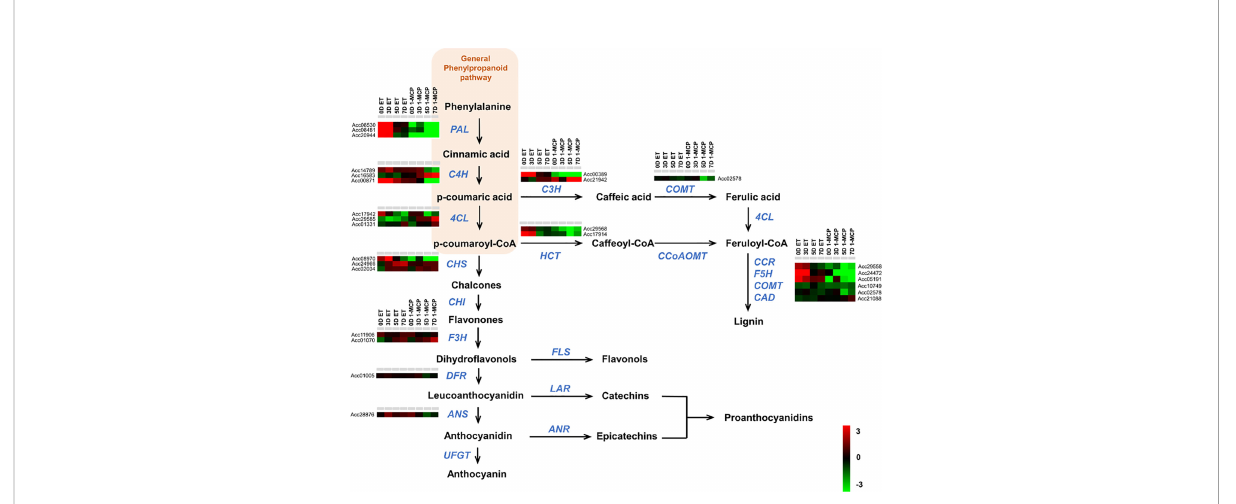
FIGURE 6 Expression pro fi les of phenylpropanoid pathway genes upon ET and 1-MCP treatment along ripening time course. Schematic diagram showing phenylpropanoid pathways beginning from general phenylpropanoid pathway constituting PAL , C4H , and 4CL genes and then subsequently branched into different biosynthesis pathways for anthocyanins, proanthocyanidins, and lignin. Gene names responsible for each step of the phenylpropanoid pathway were indicated with italicized blue-colored letters. Expression levels of genes related to each step of the phenylpropanoid biosynthesis pathway were presented as a heatmap. Red cube represents upregulated gene expression, and green cube represents downregulated gene expression compared to the level of the control sample. ET, ethylene; 1-MCP,